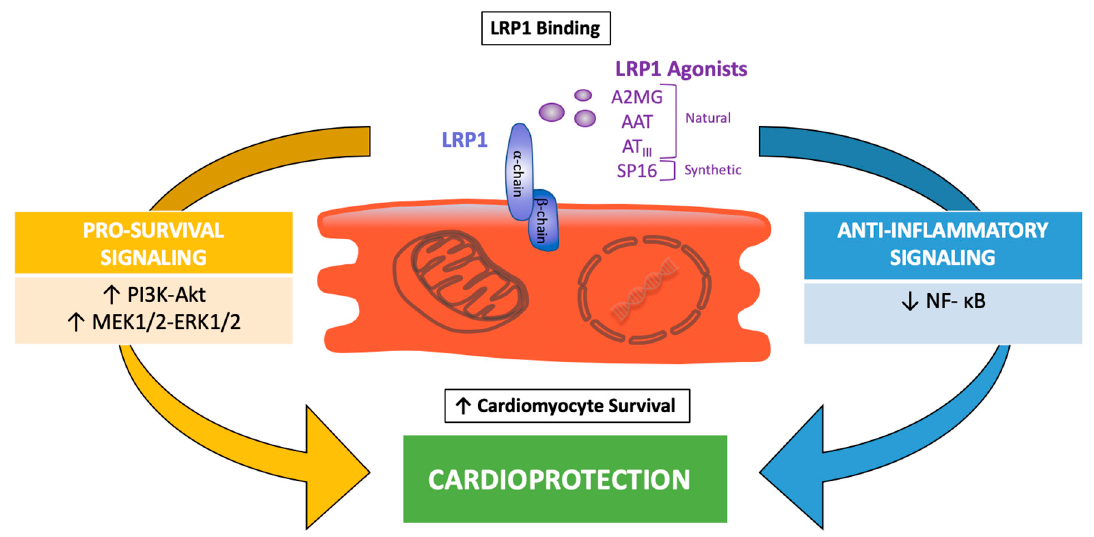
Figure 2. LRP1 protective signaling in myocardial ischemia reperfusion. Binding of natural serine proteinase inhibitors (SERPINs; α 2-macroglobulin (A2MG), α 1-antitrypsin (AAT), and antithrombin III (AT III )) and synthetic LRP1 agonists (SP16) induces cytoprotective signals in cardiomyocytes through the activation of pro-survival and anti-inflammatory signaling pathways.